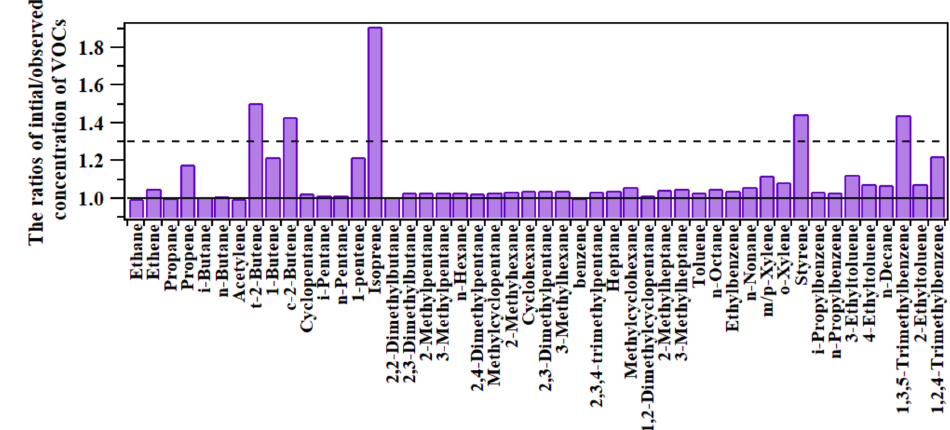
Figure 4. Ratios of initial to observed concentrations of volatile organic compounds